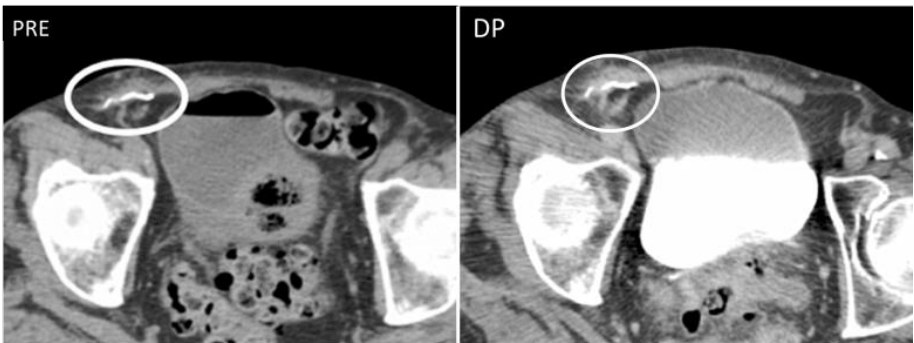
Figure 3. Granuloma occurring along a surgical mesh for an inguinal hernia repair. Axial CT on unenhanced (image on the left) and delayed phase at 10 min (image on the right) shows the formation of a nodular, fibrotic mass, with uptake contrast in delayed phases around a surgical mesh (circle).